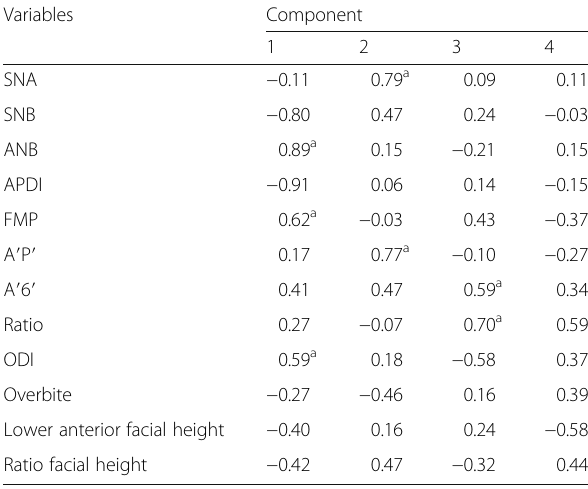
Table 6 Principal component analysis to reduce the number of variables under